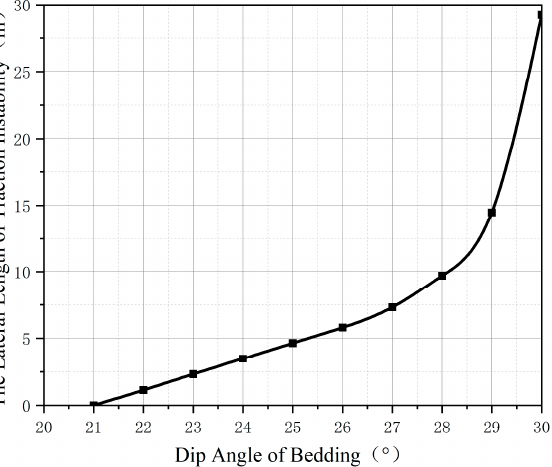
Figure 18. Influence of the Dip Angle of Bedding on the lateral length of traction instability.